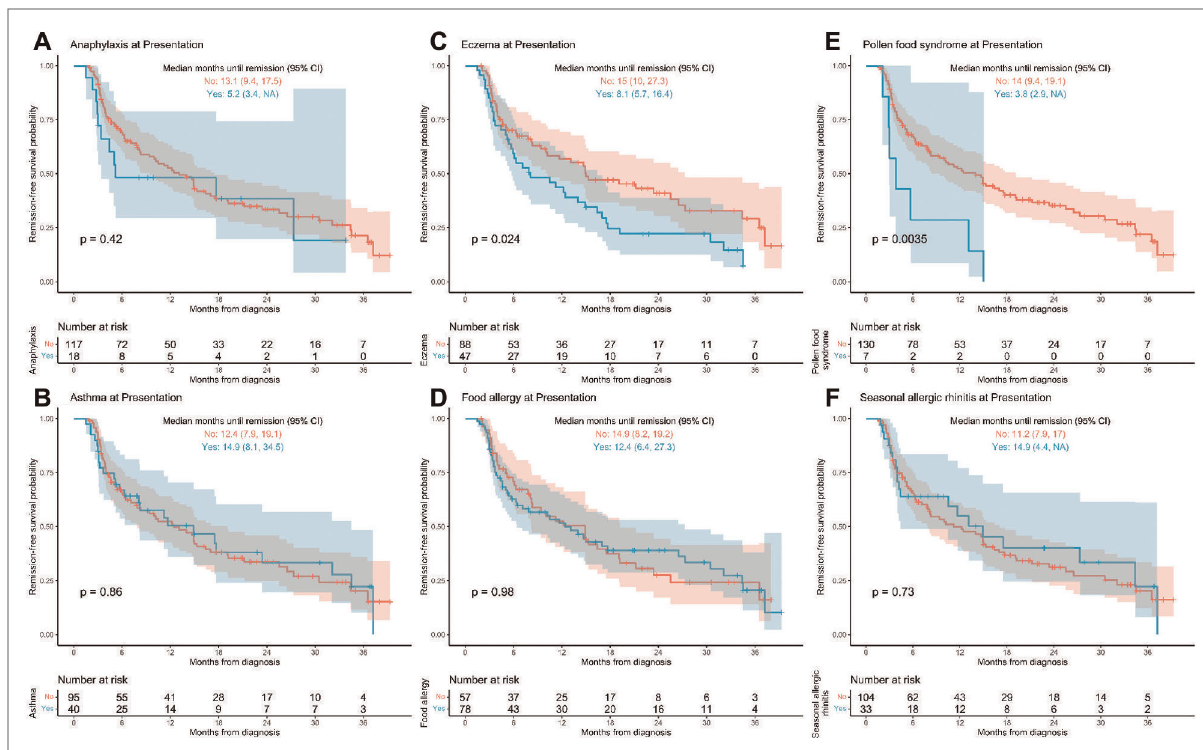
FIGURE 2 ( A – F ) Time to fi rst remission by atopic/allergic diagnoses at presentation. Kaplan-Meier curves of time until fi rst histologic remission by the six main allergic/atopic diagnoses at presentation with 95% con fi dence bands. Children that did not experience histologic remission by 3 years post-diagnosis were censored at their last available EGD visit. “ NA ” indicated that the upper con fi dence limit is unde fi